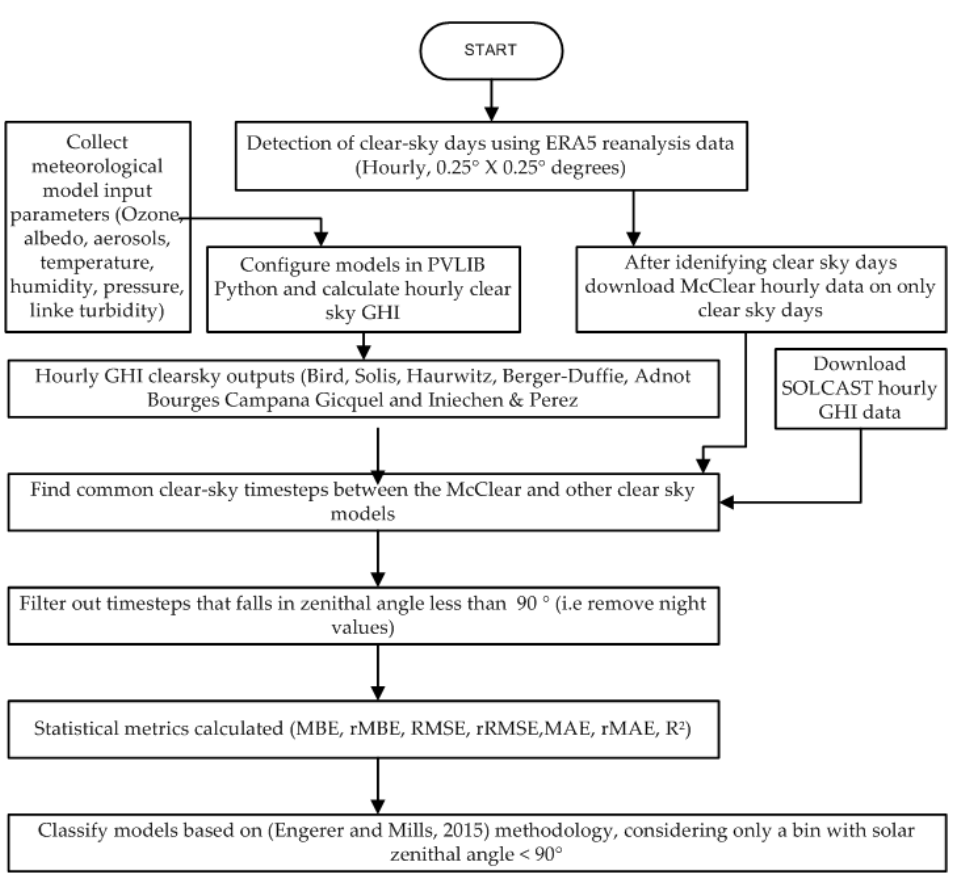
Figure 2. The schematic outline of the procedure used from model input data collection to clear sky detection, model configuration, and model data validation. Table 4. Four performance classes to rank clear sky GHI